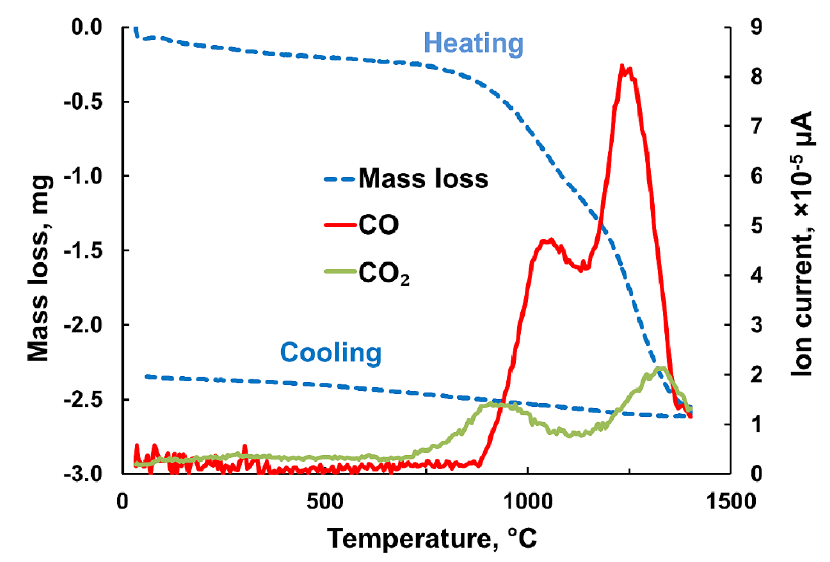
Figure 11. Mass loss and CO / CO 2 release when heating and cooling a GDC10-HP and carbon black powder mixture in argon.